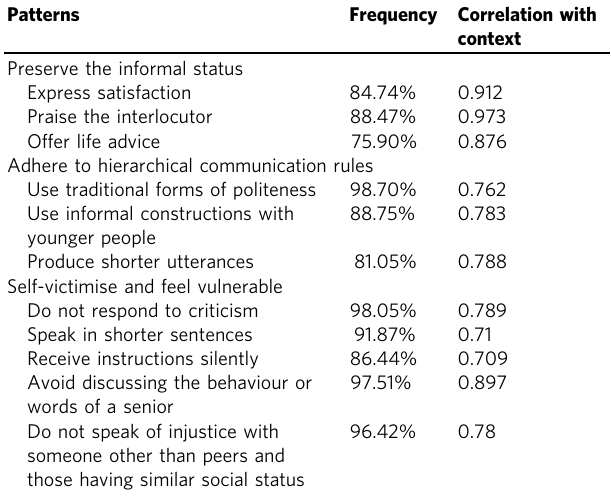
Table 3 The frequencies of beliefs/values (the percentage of utterances in the corpus) and their correlation with the context of the